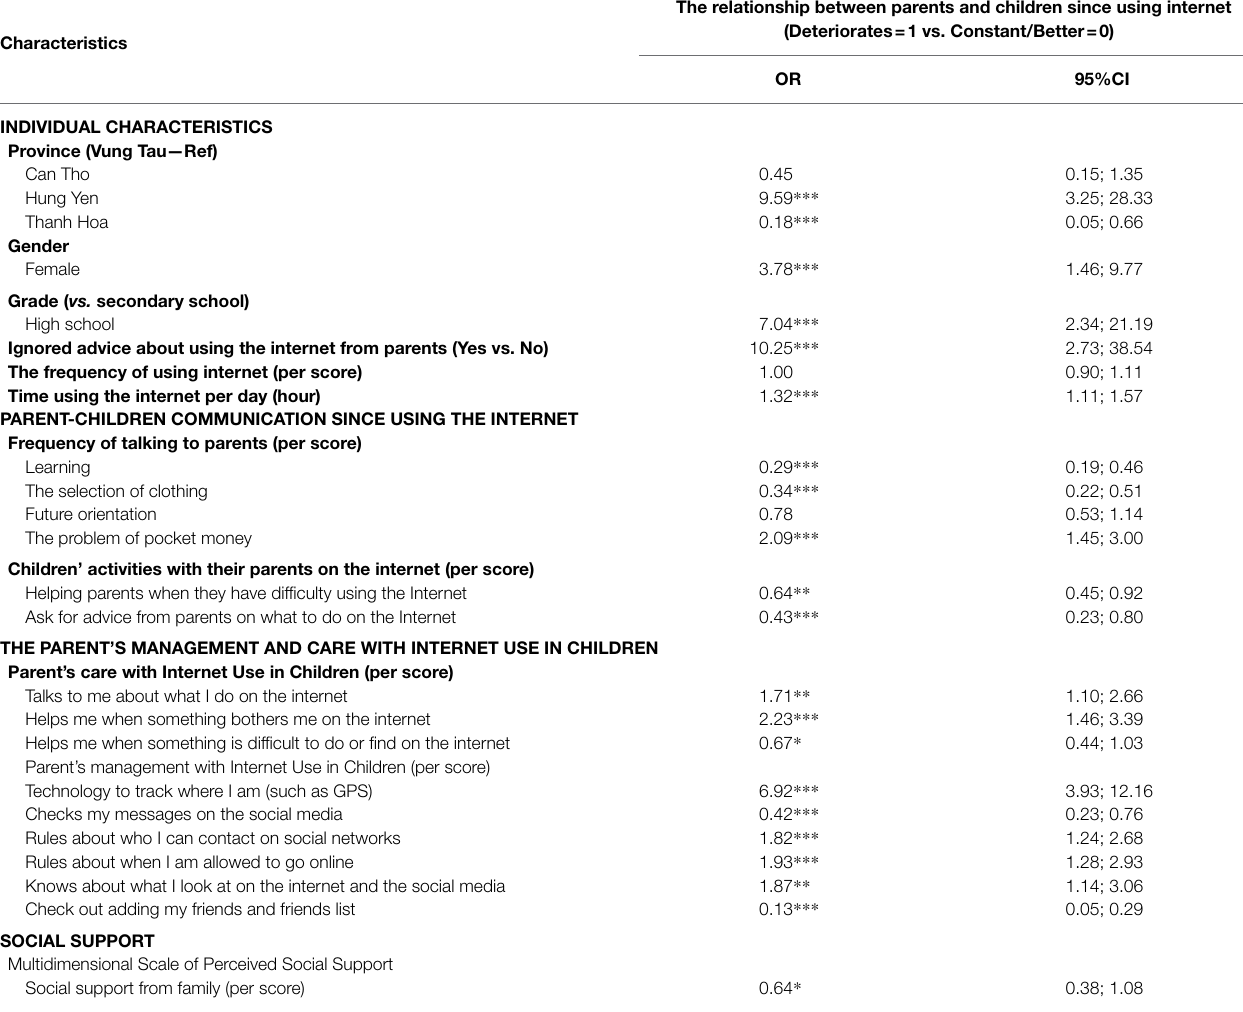
TABLE 4 | Logistic Regression for identifying factors related to the relationship between parents and children since using the internet.